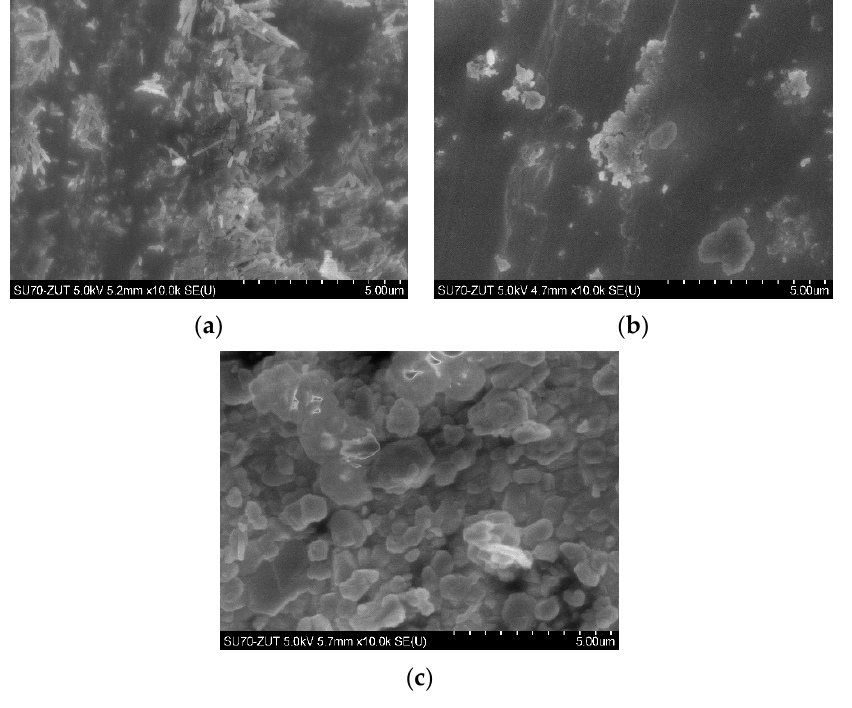
Figure 1. SEM micrographs of: HNTs ( a ), HNTs-g ( b ), and ATH-sil ( c ).